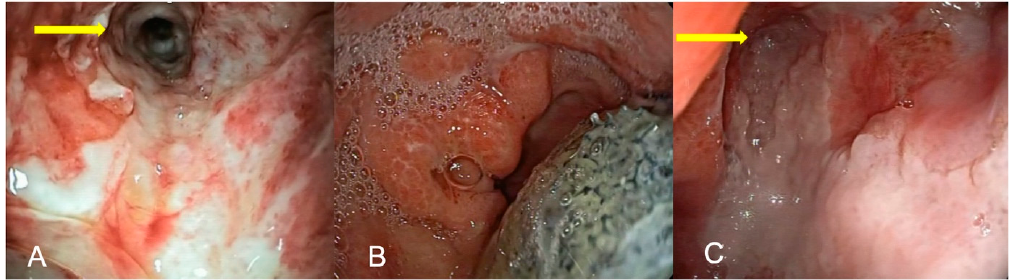
Figure 1. ( A – C ) partial closure of anastomotic esophageal defect after Ivor Lewis esophagectomy: ( A ) pleural drainage channel (yellow arrow); ( B ) EVT removal; ( C ) partial defect closure after